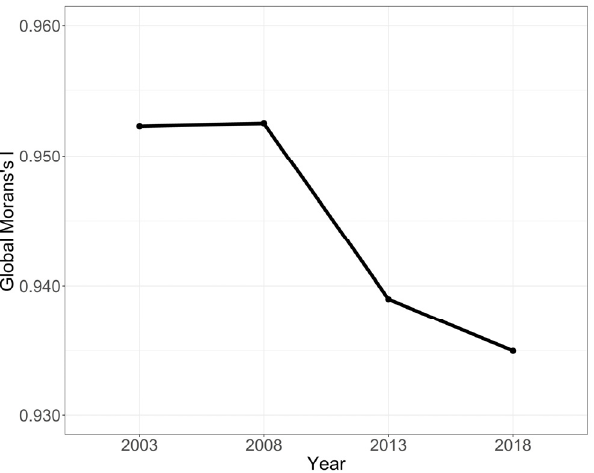
Figure 8. The global Moran’s I of NDVI in the QBM,